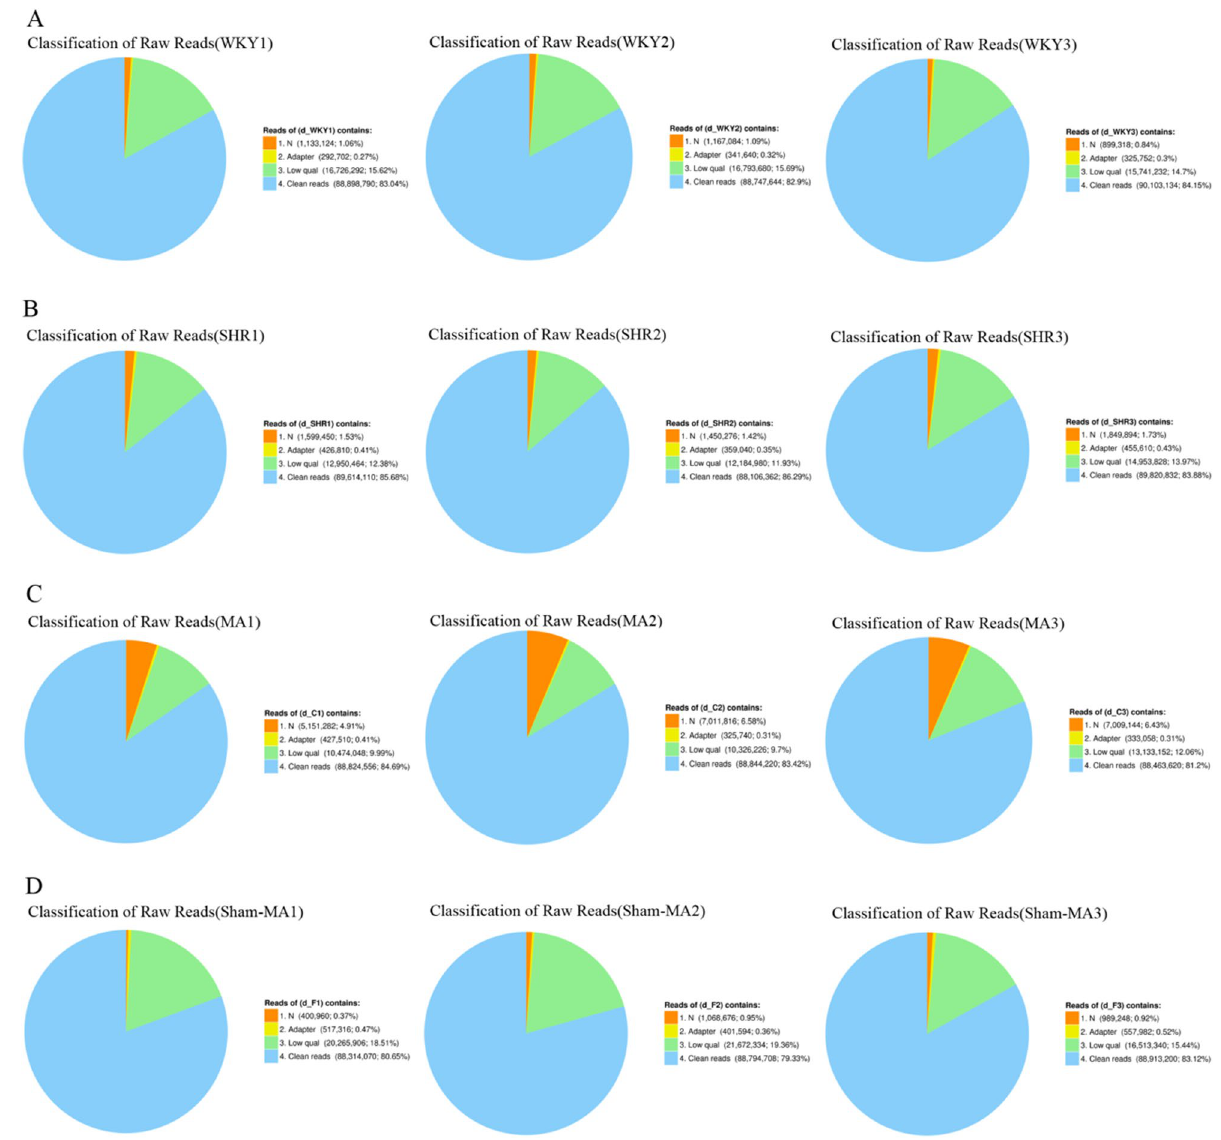
Figure 3. A summary of the original RNA-Seq data. The original data performance of the WKY ( A ), SHR ( B ), MA ( C ) and Sham-MA ( D ) group is shown in the pie chart (n = 3). N: The total amount of reads that contain more than 5% unknown N base (the N reads ratio); adaptor: The total amount of reads that contain adaptors (the adaptor ratio); low quality: More than 20% of the bases in the total read have a quality score lower than 15 (a low quality read ratio); clean reads: Reads filtered with N reads; reads have adaptors and low quality reads (a clean read groups, respectively. The proportion of clean reads was 82.9–84.15% in the WKY group, 84.15–86.29% in the SHR group, 81.2–84.69% in the MA group and 79.33–83.12% in the Sham-MA group. The clean read ratio of the rat genome suggested that the sequencing depth was satisfactory for the analysis of differentially expressed genes between the groups of rats. Differentially expressed genes in the hypothalamus of WKY, SHR, MA and Sham‑MA rats. To study the regulation of DEGs between the WKY, SHR, MA and Sham-MA groups, DEGs in the hypothalamus were analysed. DESeq2 algorithms were based on a negative binomial distribution to detect the DEGs by apply- ing a fold change ≥ 2.00 and an adjusted p-value (p ≤ 0.05). The statistics of the number of DEGs are shown by a heatmap (Fig. 4A,D,G), scatter plot (Fig. 4B,E,H), and volcano plot (Fig. 4C,F,I). There were 695 DEGs in the SHRs relative to the WKY rats, with 375 upregulated genes and 320 downregulated genes. A total of 120 DEGs were found in the MA rats relative to the SHRs, with 72 upregulated genes and 48 downregulated genes. A Venn analysis was used to study the possible genes involved in reducing blood pressure as a result of acupuncture. We found that MA treatment abolished the upregulation of 5 of the 375 genes upregulated in SHRs compared to wild-type rats. Correspondingly, MA treatment was able to counteract the downregulation of 3 of the 320 down-